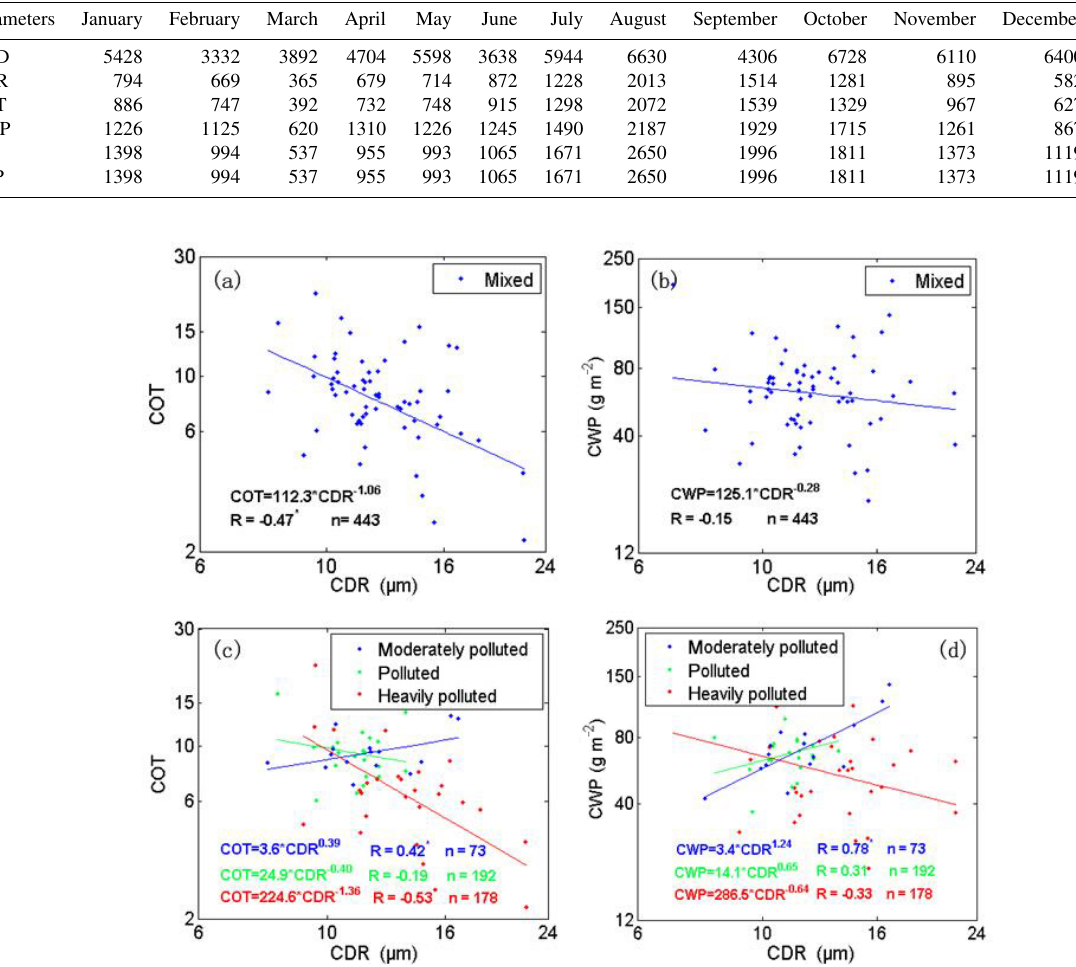
Figure 4. Scatter plots of cloud parameters versus CDR in well-mixed aerosol–cloud layers: (a) COT and (b) CWP, both for all data; (c) COT and (d) CWP, both for data grouped by moderately polluted (in blue), polluted (in green) and heavily polluted (in red) atmospheric conditions. Here moderately polluted refers to AOD<0.35, polluted refers to 0.35< = AOD< = 0.8 and heavily polluted refers to AOD>0.8. The lines present the least-square fits, and the resulting relations are presented in each figure. The number of data samples is also reported in the figure (and following